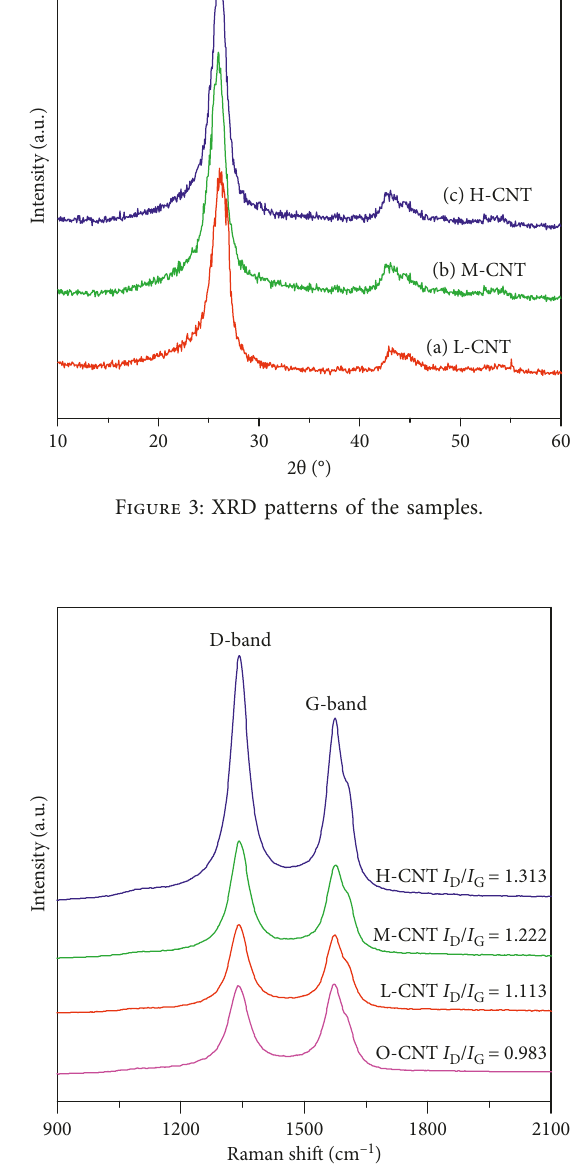
Figure 4: Raman spectra of the CNT FT-IR profiles for the modified CNTs are displayed in Figure 5. The samples exhibited similar FT-IR spectra, suggesting that they had similar structures and functional groups. A strong absorption band appeared at around 1 which was assigned to -OH stretching. The ad- 3400 cm 1 ∼ 3000 cm 1 and sorption peaks observed at 2900 cm − 1 ∼ 1760 cm 1 were attributed to -COOH group 1670 cm − − 1 ∼ 1200 cm 1 can vibrations. The peak appearing at 1000 cm − − be attributed to esters, such as those in ethers, phenols, and − − hydroxyl groups. However, all those peaks were more pronounced in H-CNT, suggesting the presence of more oxygen functional groups.